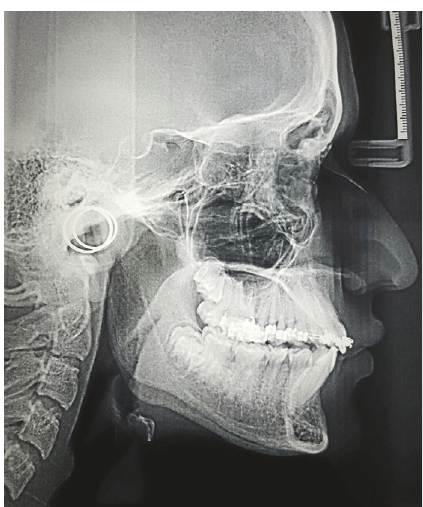
Figure 6: Cephalometric image after phase II (discontinuing Twin Block): mandibular growth is evident.